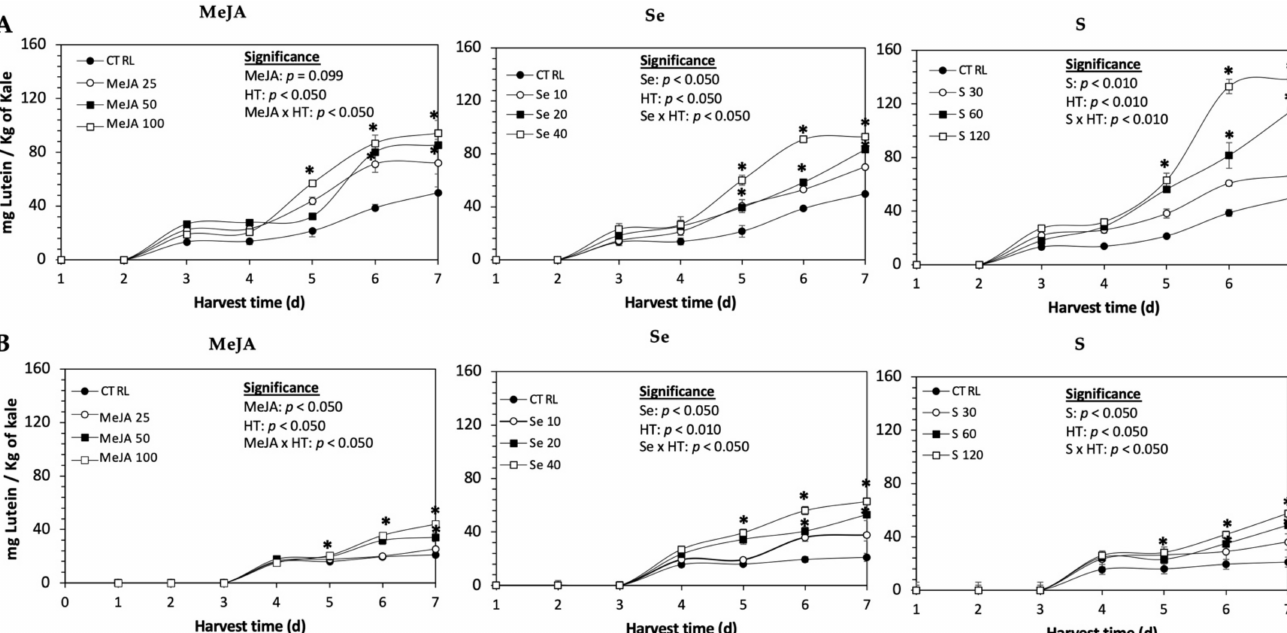
Figure 1. Concentration of lutein in untreated ( A ) Red Russian and ( B ) Dwarf Green kale sprouts and treated with methyl jasmonate, sulfur, and selenium during the first 7 days of germination. Bars are means of 3 replicates ± standard error. Data points with an asterisk (*) indicate statistical difference determined by a t -test ( p < 0.050) between the control and treated samples. Abbreviations: methyl jasmonate (MeJA), sulfur (S), selenium (Se), and harvest time (HT). Results are expressed in dry weight